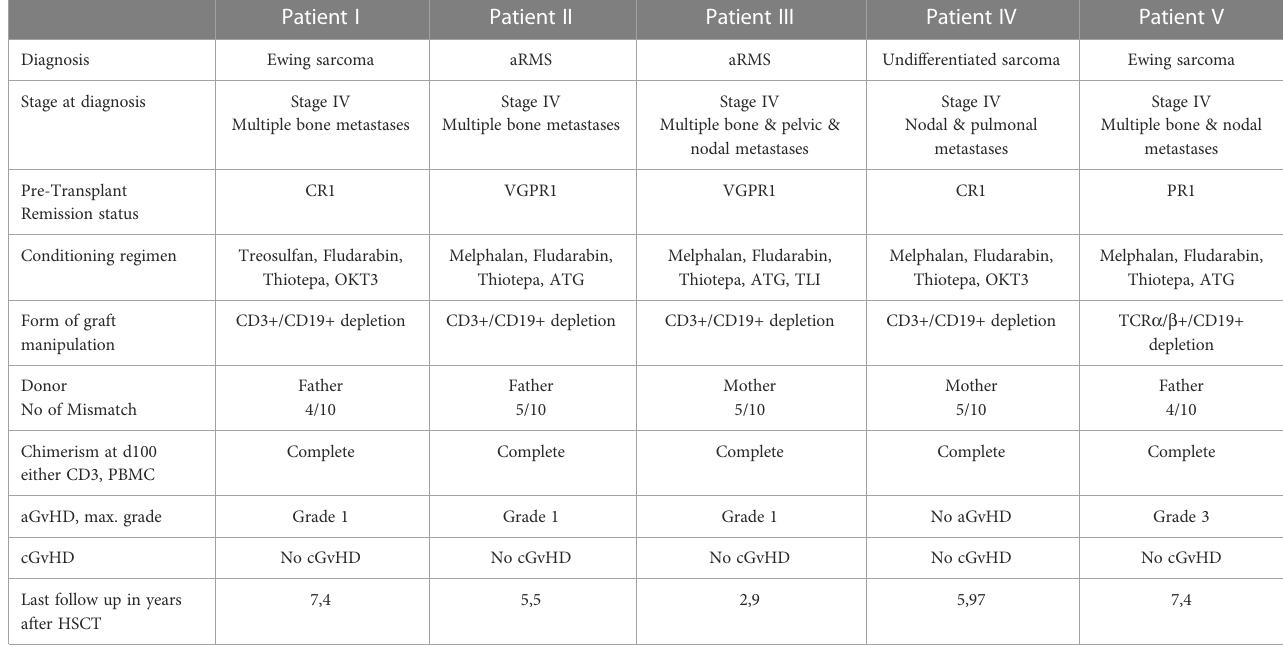
TABLE 3 Details of surviving